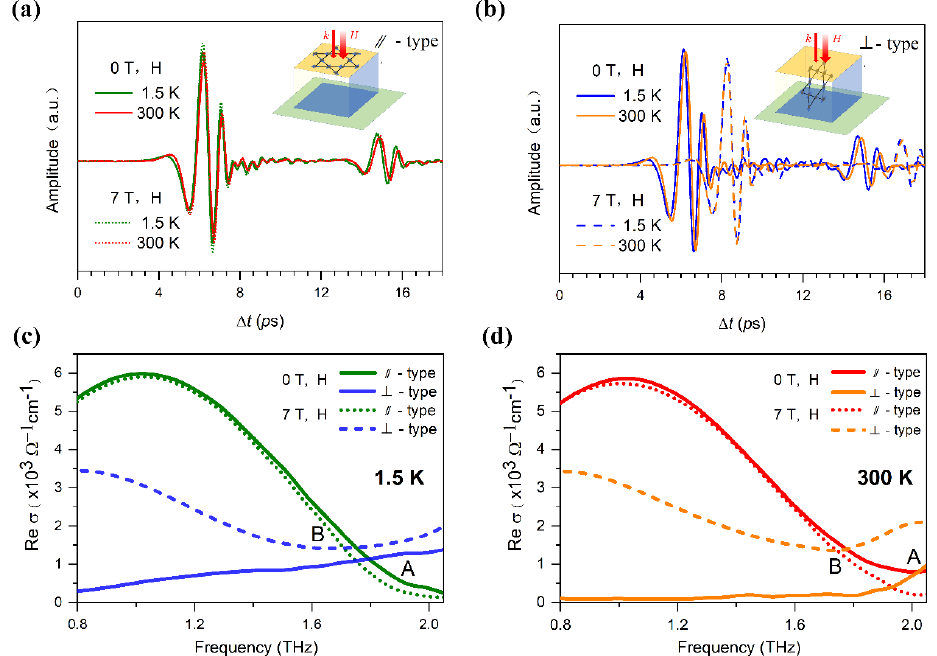
Figure 4. THz measurements of 40 nm Mn 3+0.53 Sn samples. ( a , b ) are the THz-TDS of // - and ⊥ -type samples (S5 and S4), respectively, where the abscissa Δ t is the time difference between signals of sample and the system. Inset plots are schematical illustrations for the geometric relationship in measurement between the kagome plane, the film surface, the wave vector (k) of incident terahertz wave and the external magnetic field (H). The real parts of the conductivities of // - and ⊥ -type samples are displayed in ( c ) at 1.5 K and in ( d ) at 300